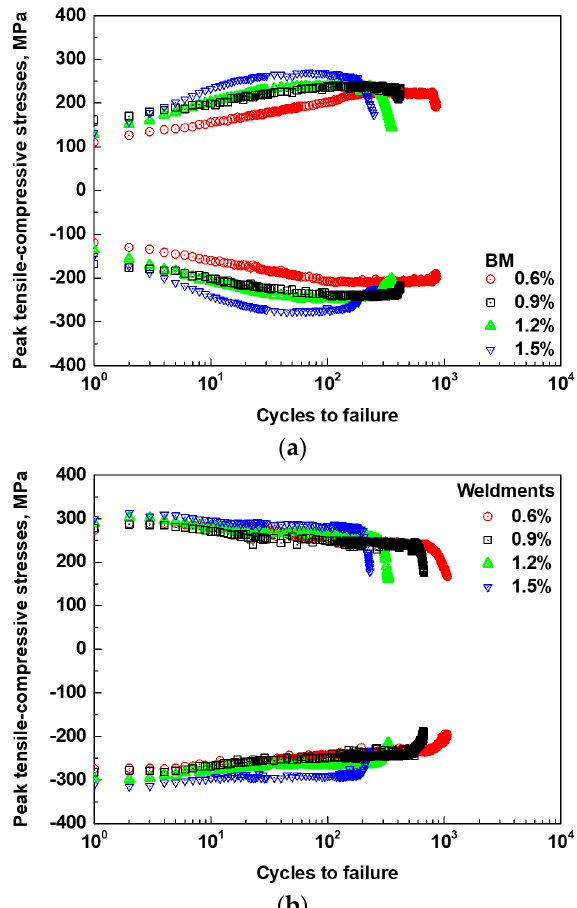
Figure 5. The peak tensile ‐ compressive stresses for Alloy 800H: ( a ) BM and ( b ) weldments.